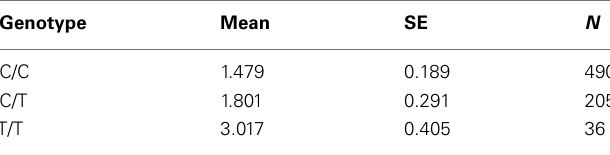
genotypes at rs2237988 ( KCNJ11 ), using model 2.